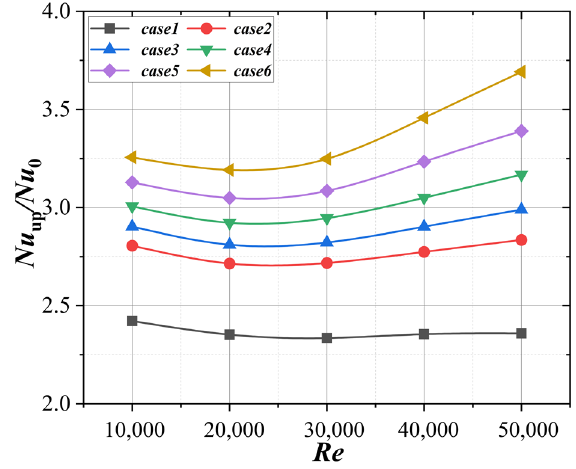
Figure 10. The variation of Nu up /Nu 0 with Re for different channels.